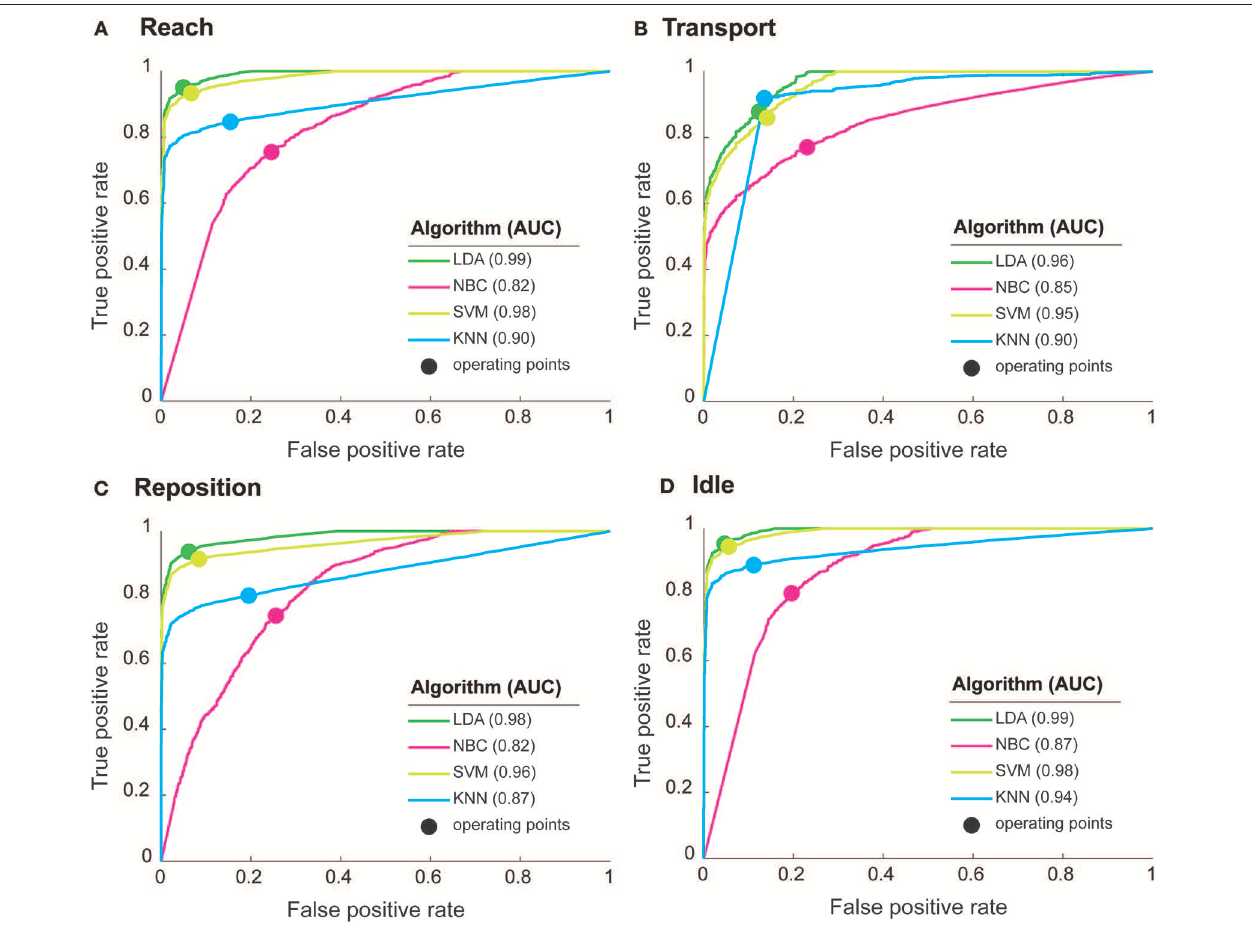
FIGURE 3 | Performance characteristics of machine learning algorithms for (A) Reach, (B) Transport, (C) Reposition, and (D) Idle. Receiver operating characteristic (ROC) curves show the trade-off between true positive rate (or sensitivity) and false positive rate (1-specificity). Curves closer to the top-left corner indicate a better classification performance. The optimal operating point for each algorithm (solid circles), reflect the best tradeoff between sensitivity and specificity for an algorithm. The area under the curve (AUC), a measure of classification performance, is shown in parenthesis for each algorithm. AUC = 1 represents perfect classification. LDA had the highest AUCs followed closely by SVM, indicating high classification performances. NBC had consistently the lowest AUCs, indicating the weakest classification